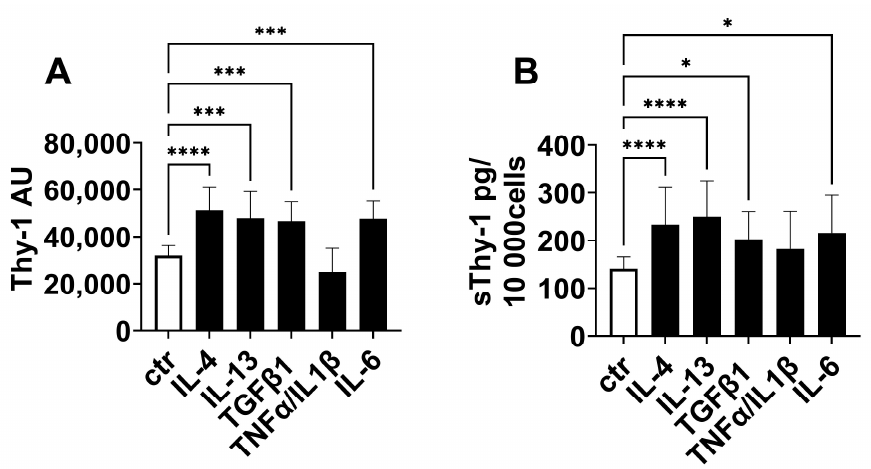
Figure 3. Thy-1 was upregulated in fibroblasts by pro-fibrotic mediators. Human fibroblasts were stimulated with interleukin (IL)-4, IL-13, IL-6, TGF β 1 or tumor necrosis factor (TNF) α /IL1 β for 9d. ( A ) Thy-1 gene expression was detected by PCR. ( B ) Soluble Thy-1 (sThy-1) was determined in supernatants by ELISA. The cell number was counted, and sThy-1 is presented as pg per 10,000 cells. Results are shown as mean ± standard deviation. p -values were assessed by one-way ANOVA test. N ≥ 5 per group. * p < 0.05; ** p < 0.01; *** p < 0.001, **** p < 0.0001.